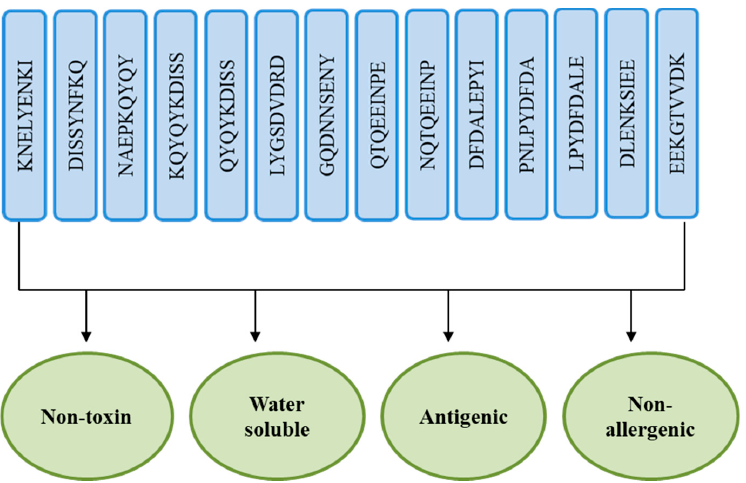
Figure 5. Fourteen shortlisted epitopes for the construction of a multi ‐ epitopes based vaccine.